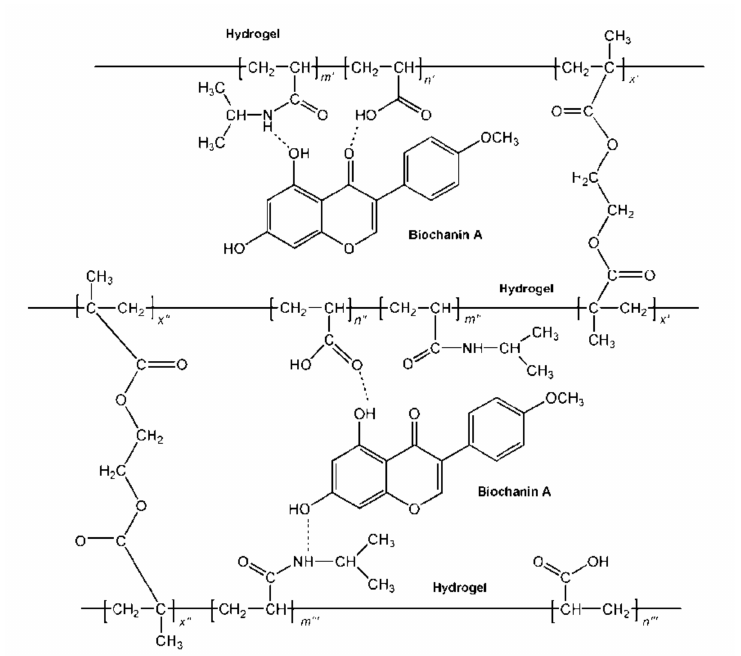
Figure 13. The structure of p(NIPAM-co-AA) copolymer with incorporated biochanin